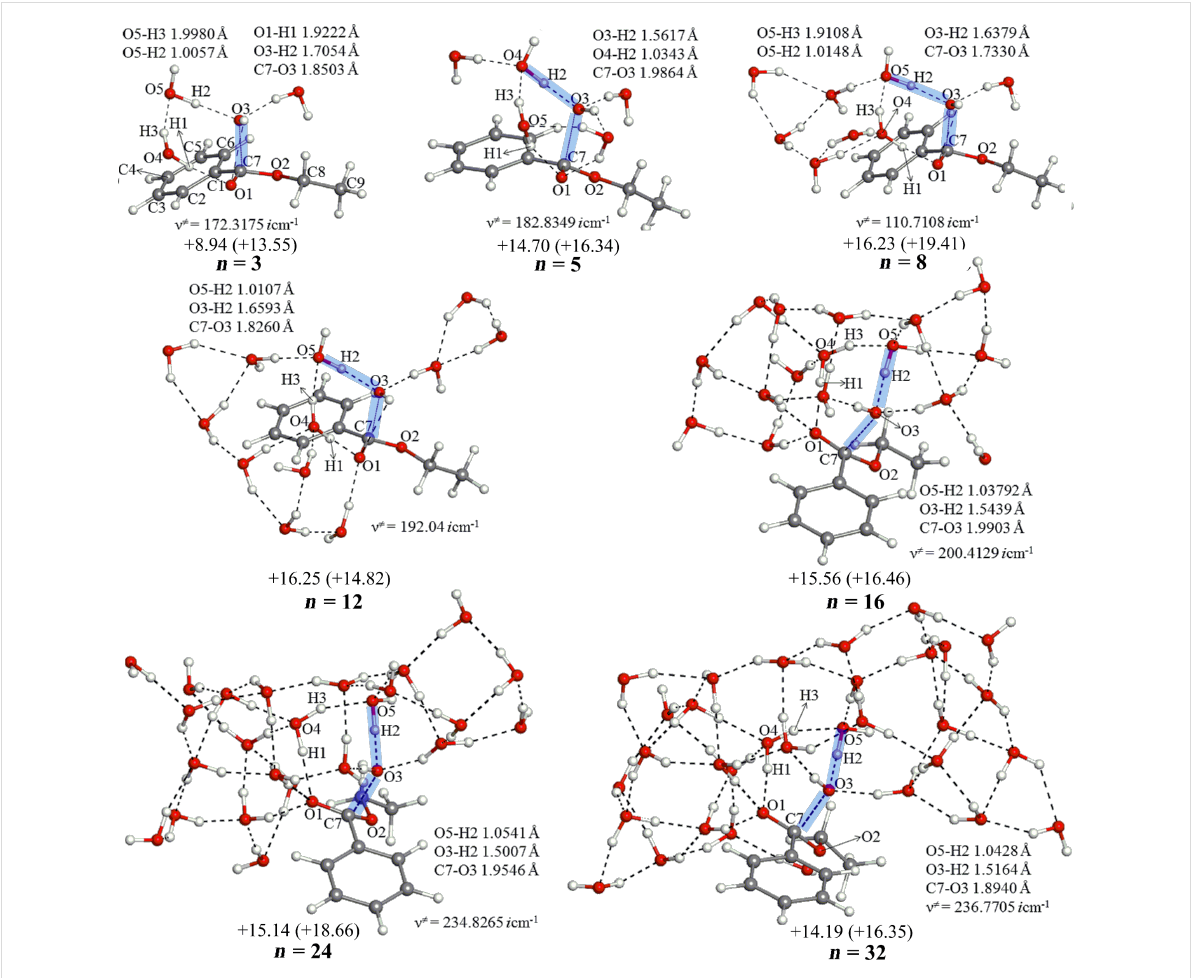
Figure 2: Geometries and B3LYP/6-31(+)G(d) activation energies of TS1(es) in the reaction between ethyl benzoate and OH − (H 2 O) n . Activation and activation free energies in kilocalories per mole (1 kcal = 4.184 kJ) are shown without and with parentheses, respectively. For instance, E a = + 8.94 kcal/mol and Δ G ≠ = + 13.55 kcal/mol for n = 3. Cartesian coordinates of all the TS geometries are shown in VII.a (Supporting Information File 1).